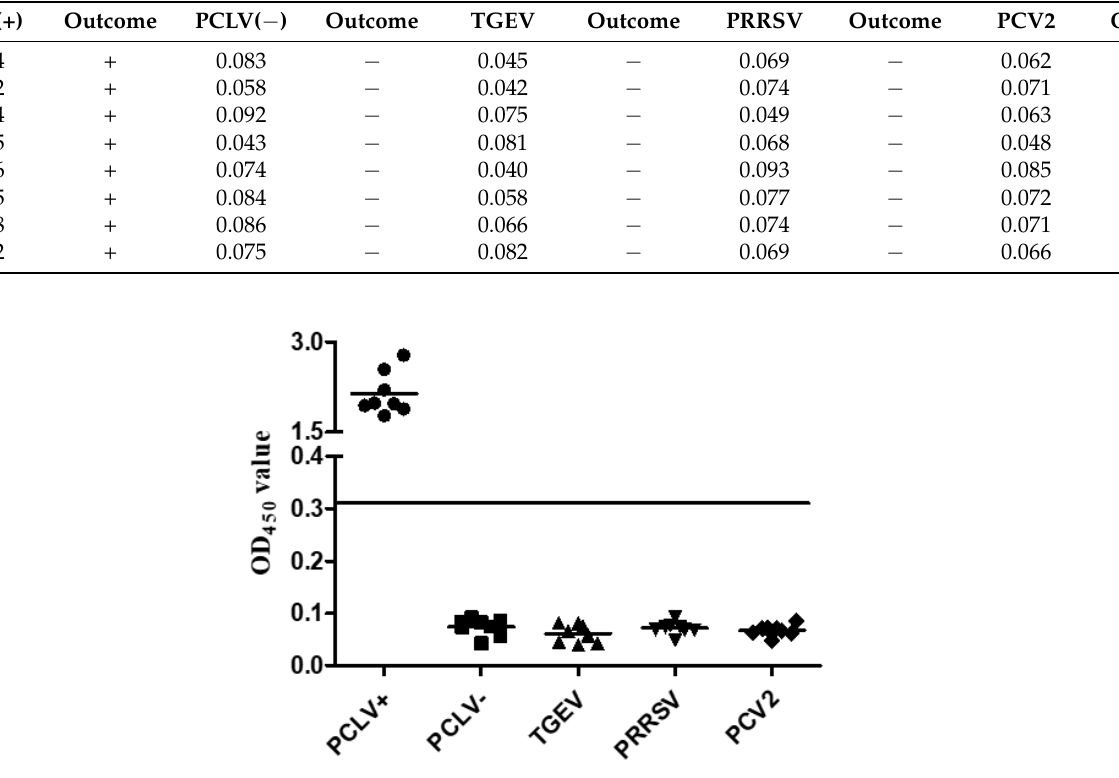
Table 2. Elucidation of the specificity of this indirect ELISA.